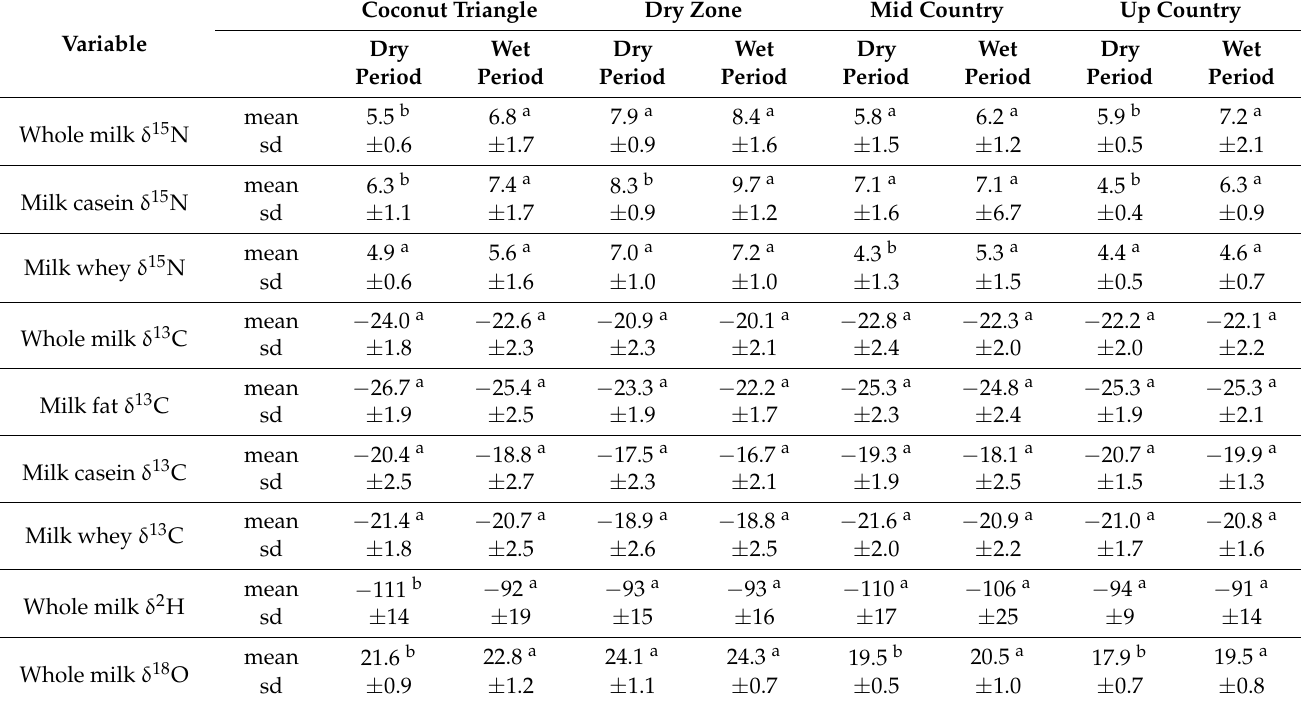
Table 3. Variation of mean δ 13 C, δ 15 N, δ 18 O, and δ 2 H in milk and milk components in each agrocli- matic region for samples collected at dry period and wet period (values of the wet and dry season in each agroclimatic zone with different superscript letters differ for p <